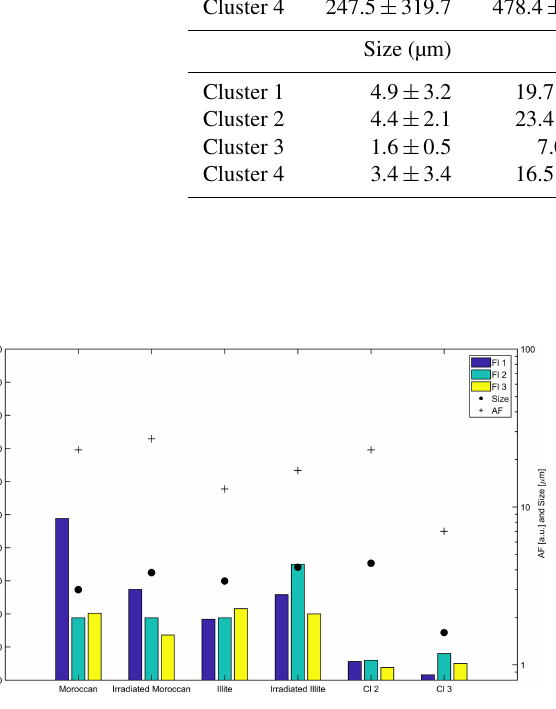
Figure 6. Mean fluorescence, size and shape properties of the four dust samples put through the WIBS-4M in a laboratory environment and their comparison to the two dominant long-term campaign clus- ters – Clusters 2 and